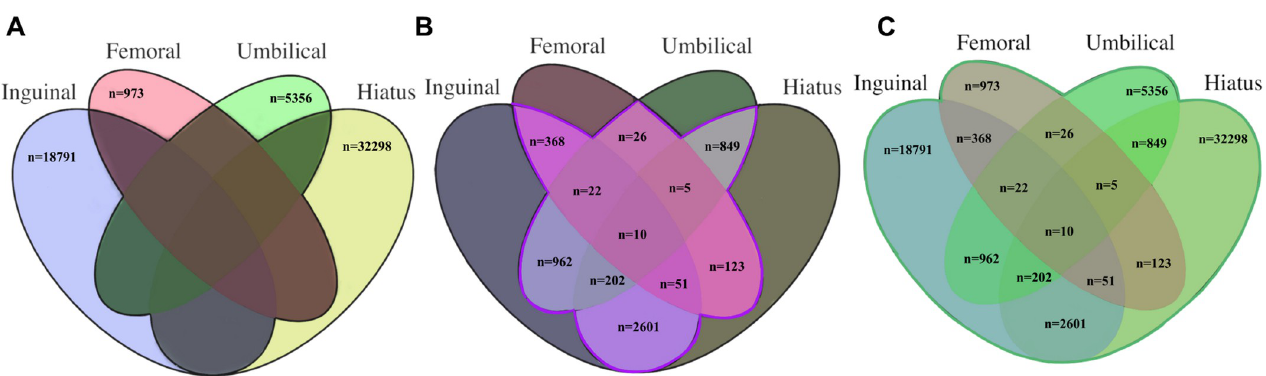
Fig 1. Individual, overlap and umbrella case-control cohorts in the UK Biobank. A: Individual hernia cohort: 57,418 individual hernia cases were matched to 287,090 controls. Participants with more than one hernia phenotype coding were excluded (dark shading). B: Overlap hernia cohort: 5,219 participants possessed coding for at least 2 hernia phenotypes and were included in the overlap hernia cohort and matched with 26,095 non-hernia controls. All cases with single phenotype coding were excluded (dark shading). C: Umbrella hernia cohort, 62,637 participants had diagnostic or operative coding for any hernia type including those with single or multiple hernia and were matched to 313,185 non-hernia